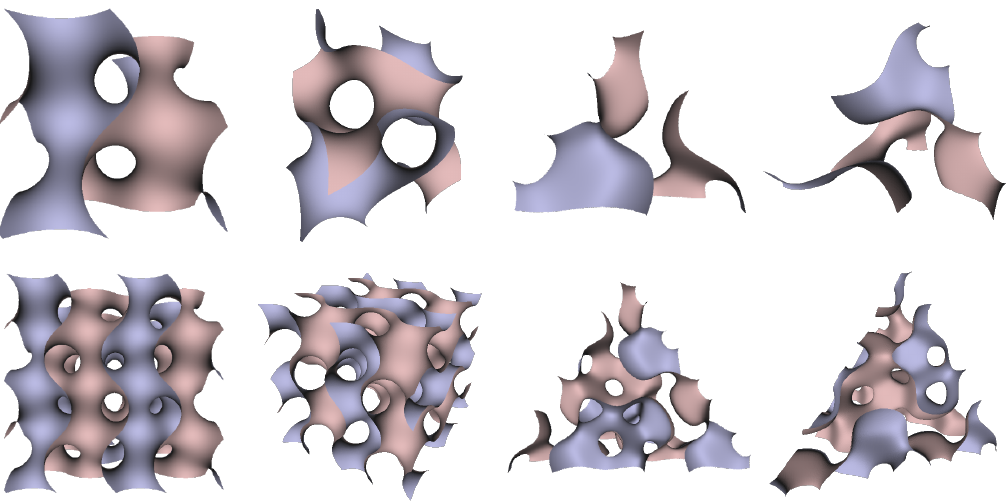
Figure 7. TPMS Schwarz G Surface (left two columns) vs. TIS G Surface (right two columns).